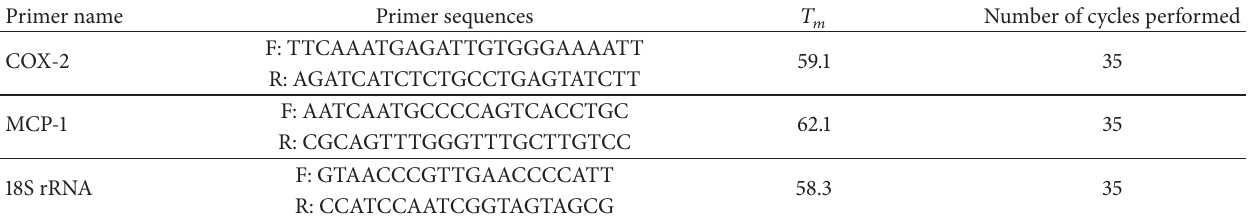
Table 1: Primer sequence of cyclooxygenase-2 (COX-2), monocyte chemoattractant protein-1 (MCP-1), and 18S rRNA gene used in this study.